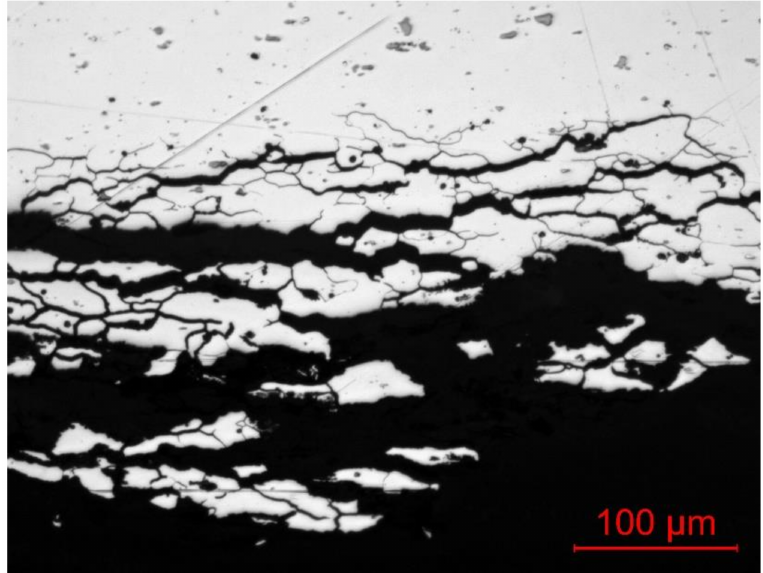
Figure 3. Exfoliation corrosion on AA 2024